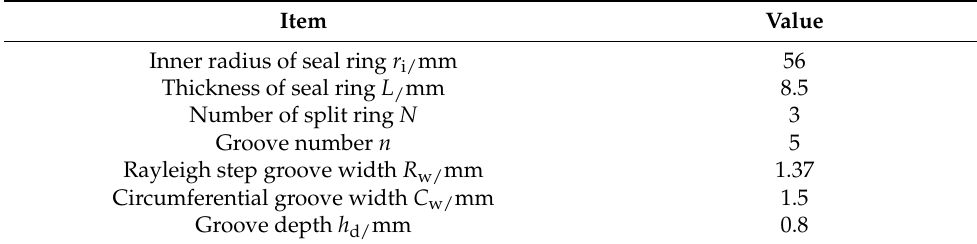
Table 1. Main parameters of the seal ring and Rayleigh step groove. Item Value